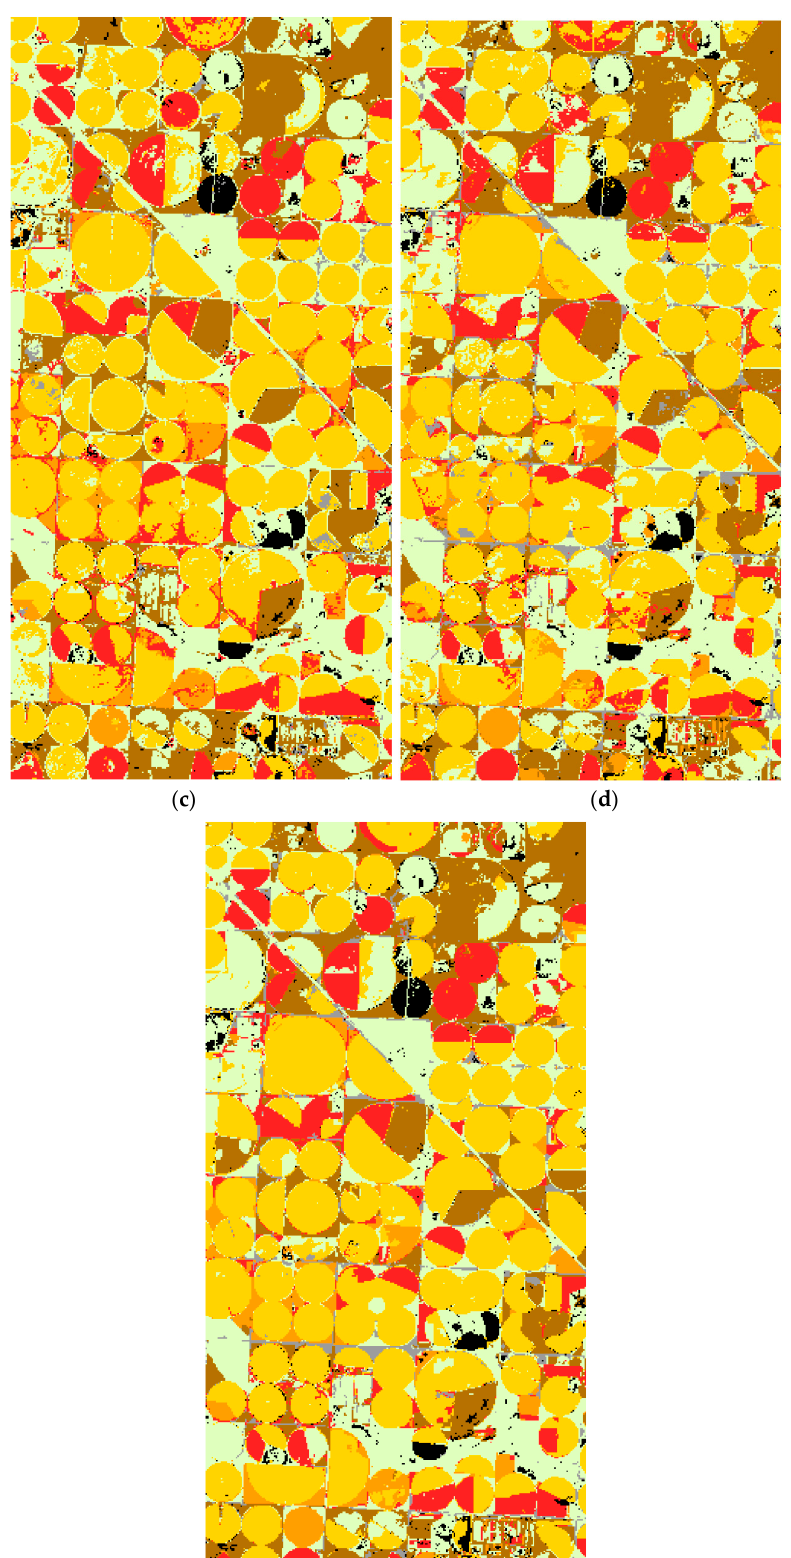
Figure 10. Texas classification results. Yellow = corn; brown = winter wheat; gray = developed/open space; pale green = grass/pasture; orange = sorghum; red = cotton; black = background (CDL classes covering ≤ 2% of the study area). ( a ) TI. ( b ) PCA. ( c ) LE-SAM-R. ( d ) LE-DTW. ( e )